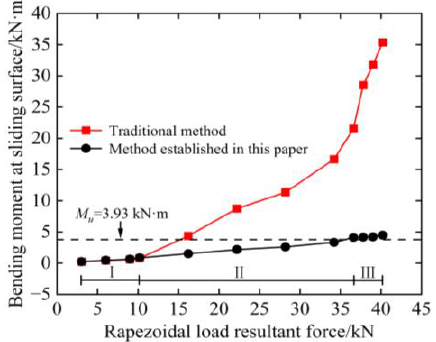
Figure 21. Comparison of the maximum bending moments of the test pile based on the traditional method and the optimized calculation method.